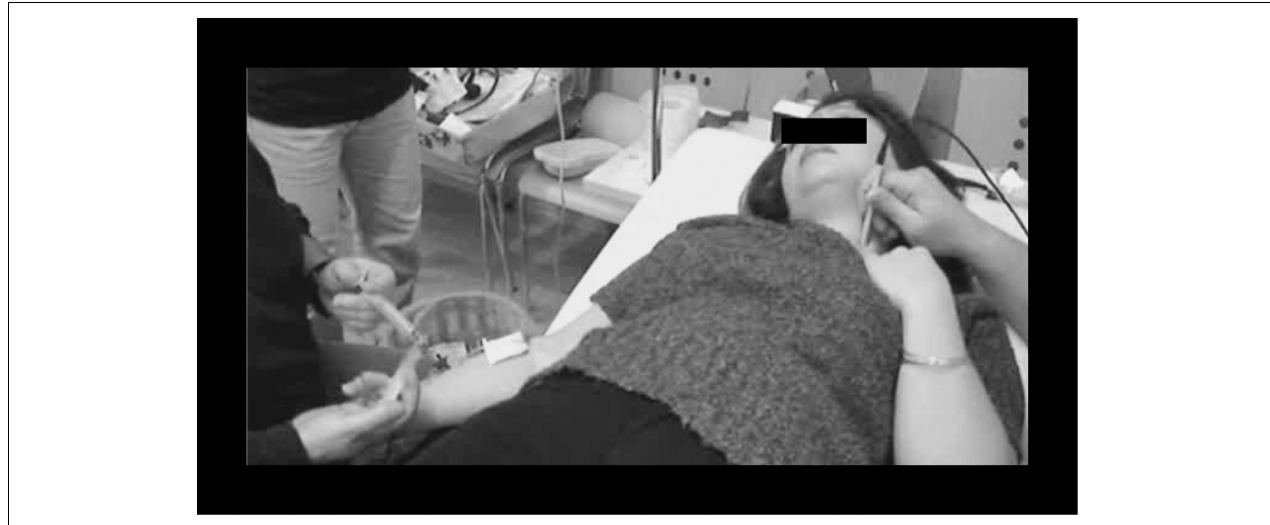
FIGURE 2 | Carotid Doppler test. Right arm: injection of contrast medium (10 mL of agitated saline solution); Left carotid artery: 8 MHz Doppler